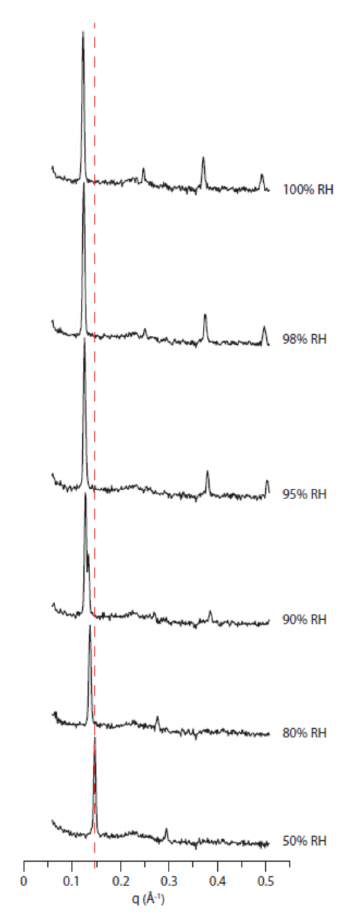
Figure 2. 1D neutron diffractogram as a function of relative humidity (RH). DoPhPC:DoPhPE (9:1) di ff ractograms after background subtraction obtained by neutron di ff raction at 25 ◦ C as a function of relative humidity. The samples were hydrated with 8% D 2 O. The Y-axis intensity is (a.u.) at decimal log scale. The dotted line is a guide for the eye to show the Bragg peak